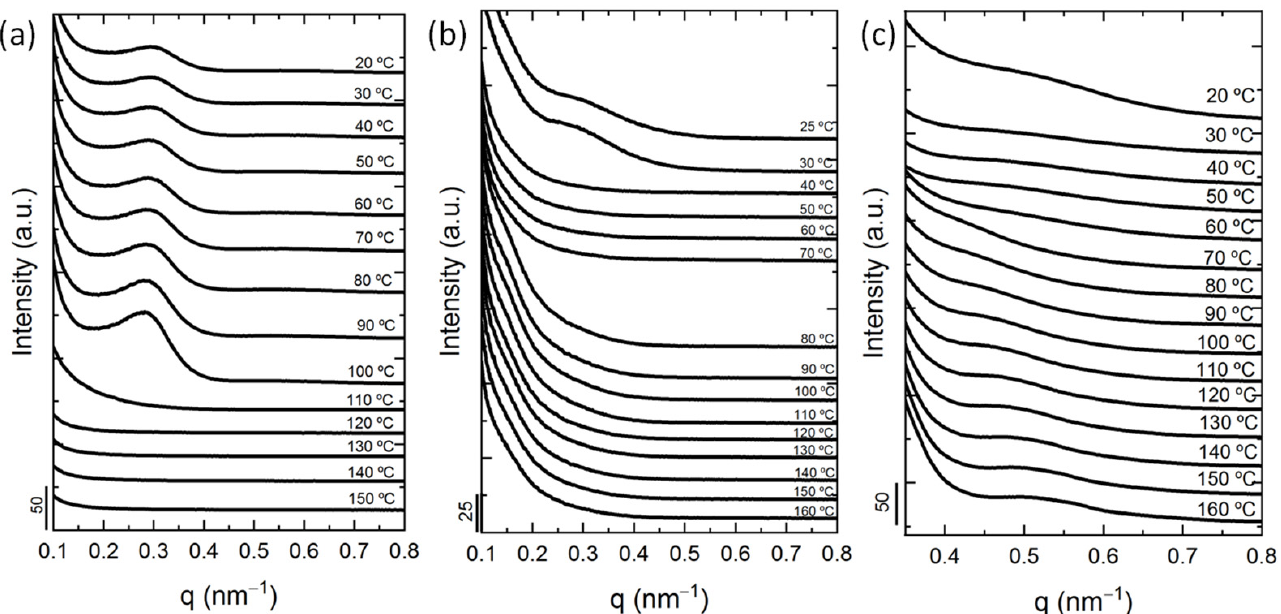
Figure 2. SAXS ramp down patterns at 20 °C/min for ( a ) PE 9.5 , ( b ) PE 529.5 -b- PEO 488.8 , and ( c ) PE 379.5 -b- PEO 348.8 -b- PCL 297.6 (T2) at the indicated temperatures. The diblock copolymer PE 529.5 -b- PEO 488.81 (Figure 2b) and the triblock terpolymer PE 379.5 -b- PEO 348.8 -b- PCL 297.6 (T2) (Figure 2c) are phase segregated in the melt, with possible lamellar and interpenetrated morphologies, respectively, although more detailed analysis of the scattering curves would be needed to ascertain the exact melt morphology. The clear scattering peaks in the molten state in these two materials corroborate the phase segregation behavior; however, their phase segregation is weak, since when the first block crystallizes upon cooling, i.e., the PE block at 100 ° C, the phase structure is destroyed, the one generated by phase segregation in the melt, as deduced by the change in q values and intensities of the scattering peaks.